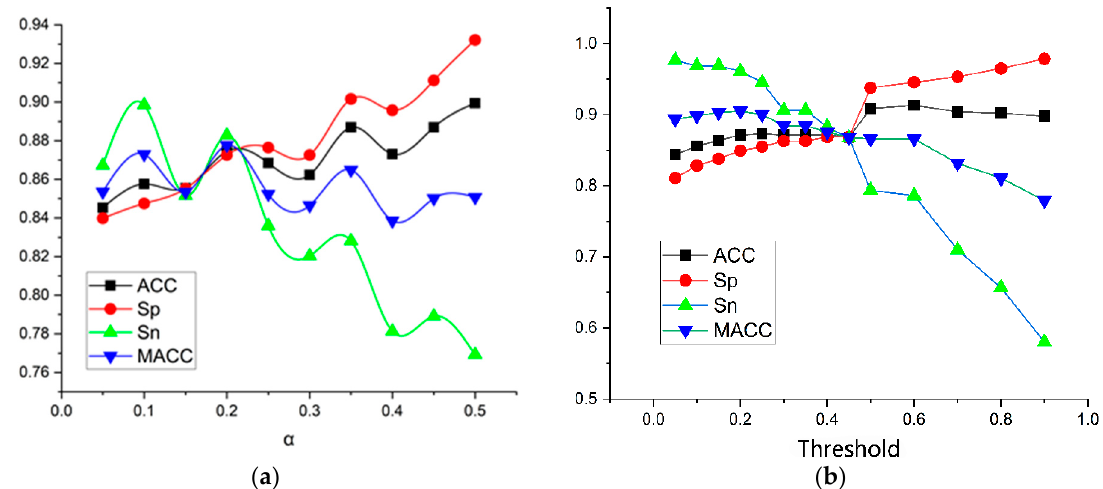
Figure 6. Impacts of different weights ( α ) and thresholds on the classification results. ( a ) Effects of different weights α on the classification results. ( b ) Impacts of different thresholds on the accuracy of the results.